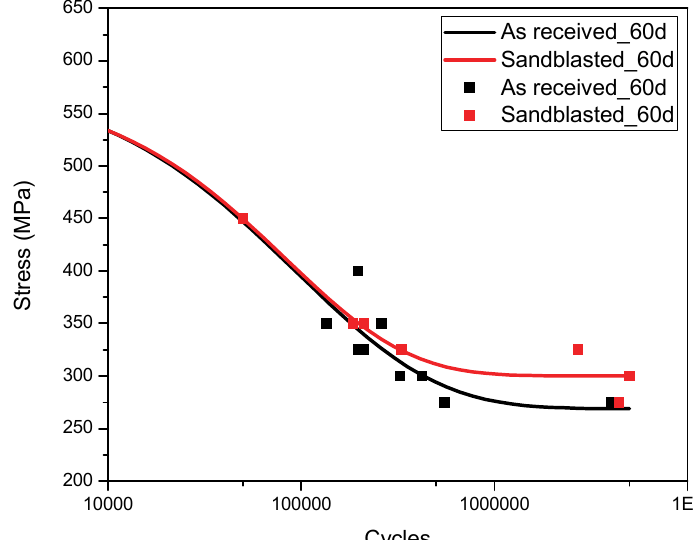
Figure 16: Fatigue results of the as-received as well as the sandblasted material at all corrosion exposure periods.